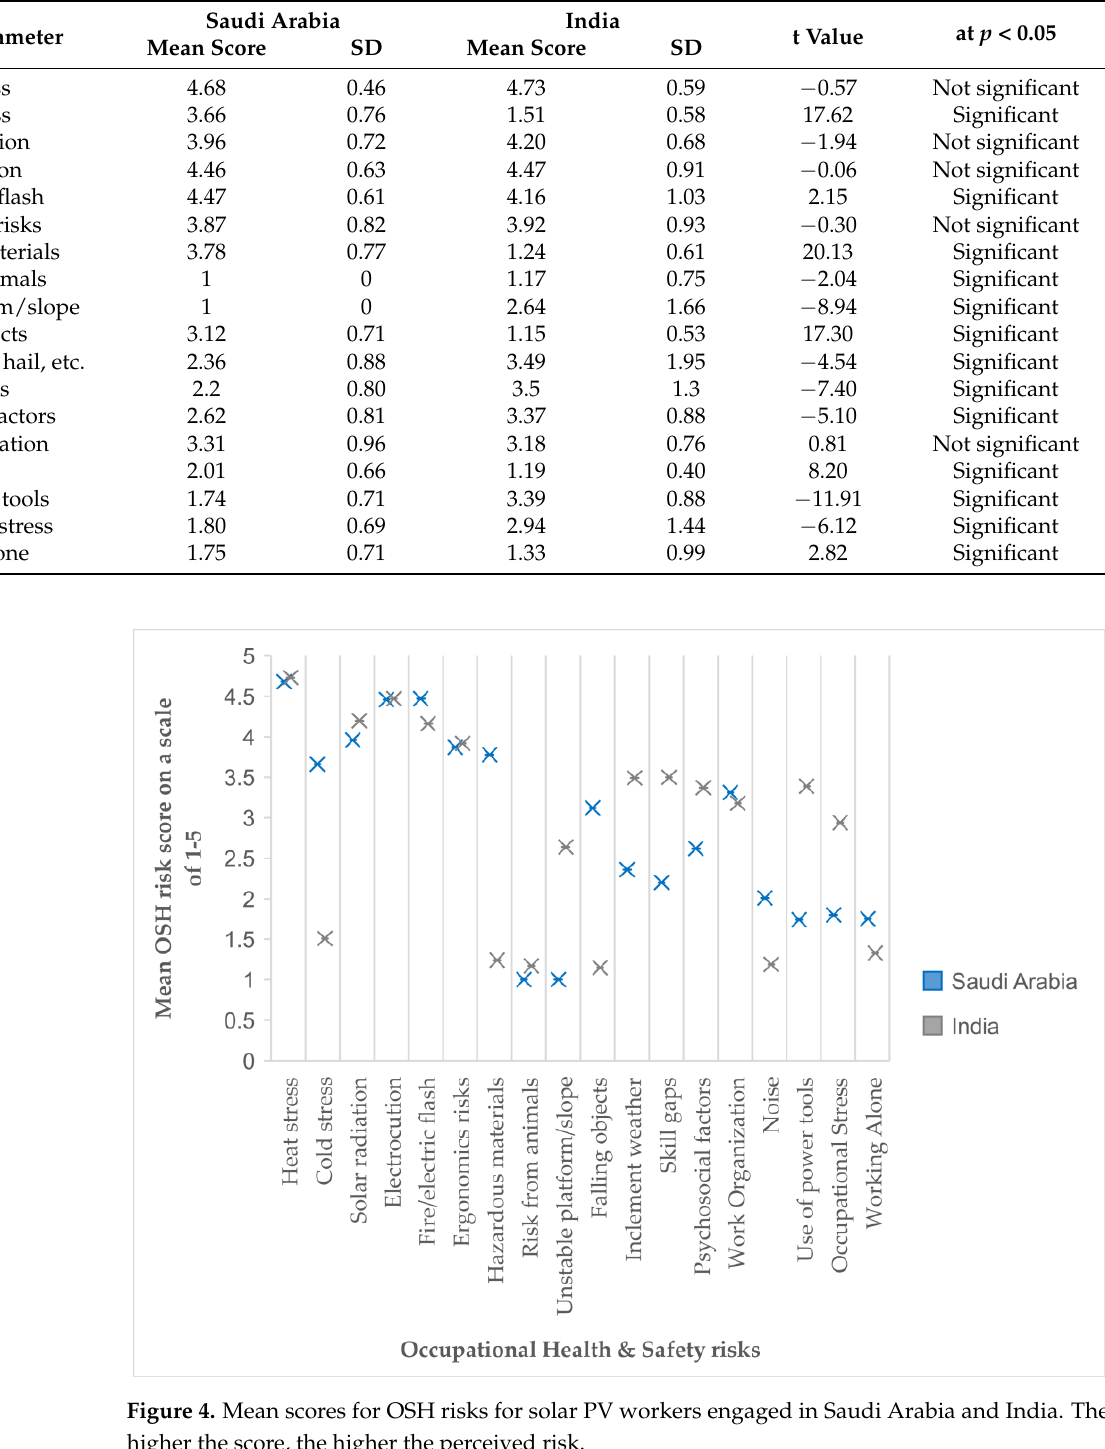
Table 3. Summary of the comparison of means between the two groups of workers.